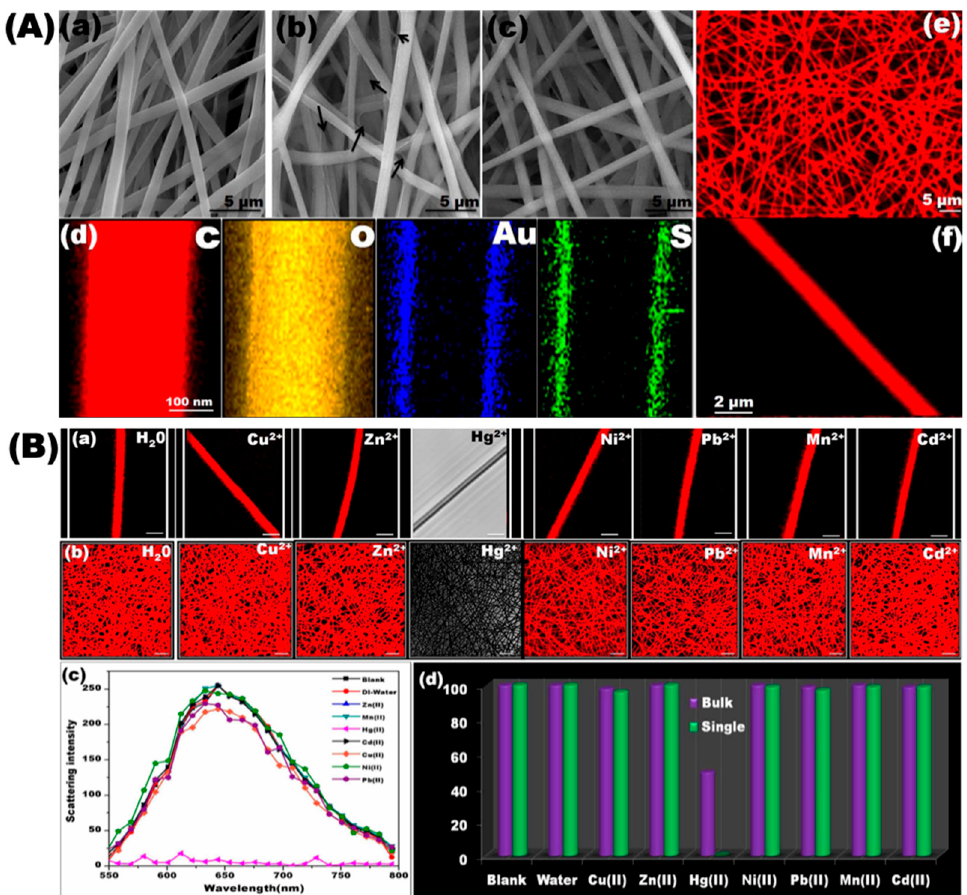
Figure 10. ( A ) Representative SEM images of the electrospun PCL-NF ( a ) gold nanocluster (AuNC) coated PCL-NF (AuNC*PCL-NF) in the presence ( b ) and absence ( c ) of excess BSA ligand. The arrow indicates the excess amount of weakly-adsorbed ligand across the NF surface. ( d ) HAADF-STEM elemental mapping of the C, O, S, and Au elements present in the AuNC*PCL single NF, shows AuNCs are consistently anchored on the surface of NFs. ( e ) Fluorescence image of AuNC*PCL-NF taken using a CLSM, excited at 488nm. The red color emitted is owed to the characteristic emission of AuNC. ( f ) CLSM image of the AuNC*PCL single NF confirms the uniform bright fluorescent feature throughout the NF surface. ( B ) Selective sensing performance of AuNC*PCL-SNF and the AuNC*PCL-NF mat. The CLSM image presents the fluorescence response of AuNC*PCL-SNF ( a ) and the AuNC*PCL-NF mat ( b ) to various metal ions (indicated in each image) at concentrations of 10ppm. (Scale bar ( a )—2 µ m, and ( b )—5 µ m; note: for Hg 2 + only, DIC images are given since fluorescence is completely quenched and CLSM images become fully black.) The H 2 O treated AuNC*PCL-NFs show their stability and proves that the decreased fluorescence upon the addition of metal ions is not because of solvent. ( c ) Variation in the emission spectra of di ff erent metal ions treated with AuNC*PCL-SNF. ( d ) Bar diagram illustrating the relative variations in the fluorescence intensity of the single NF and nanofibrous mat. Reprinted from [53] 2015, Springer Nature Publishing AG.